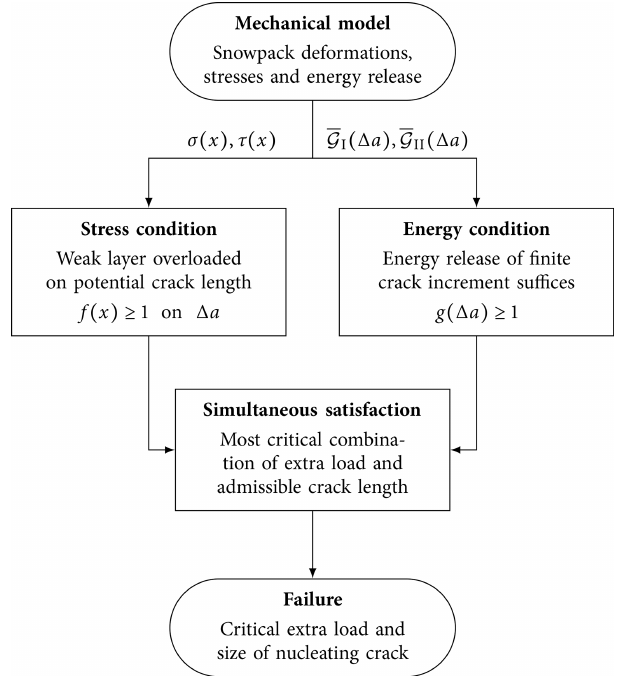
Figure 4. Solution of the coupled stress and energy criterion for an- ticrack nucleation. The model presented in the first part of this work provides required stresses and energy release rates. Using the given closed-form analytical solutions, the minimum critical skier force satisfying both conditions can be identified efficiently by employ- ing optimization